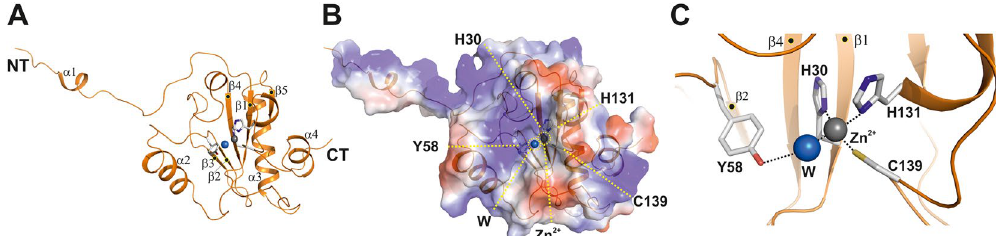
Figure 3. The crystal structure of Ts2631 endolysin shows a conserved peptidoglycan binding site. ( A ) Structure of the globular protein presented in a cartoon representation with the extended N-terminal tail comprising a short α -helix, α 1 (marked NT and α 1). The secondary structure assignment to the mixed α / β structure is α 1/ β 1/ β 2/ α 2/ β 3/ β 4/ α 3/ β 5. The β -sheet is sandwiched between helices α 2 and α 4, collectively enclosing the active site with the tetragonally coordinated zinc ion (zinc ion represented by a gray sphere; residues are shown in stick representations) in the center of the structure. ( B ) Surface representation of Ts2631 endolysin demonstrating positively charged patches at the N-terminus and around the active site, which is formed by residues His30, His131, Cys139 and a water molecule (W; blue sphere). ( C ) Expanded view of the active site in the same perspective as in ( A , B ), with the active site residues numbered and the zinc ion marked. All structure figures were prepared using PYMOL